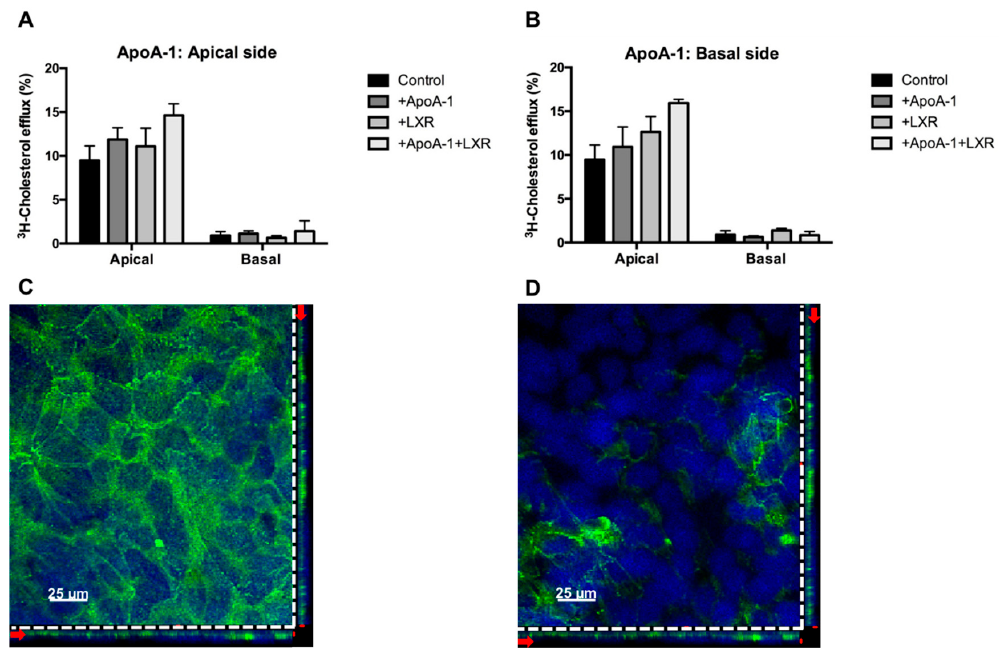
Figure 5. Transport activity and localization of ABCA1 in human primary trophoblast cells polarized on Transwell ® system. ( A , B ) The confluent trophoblast monolayer was loaded with 1 µCi of 3 H-cholesterol at the apical side for 24 h. After equilibration, 10 µg/ml of apoA-1 was added to the apical panel ( A ) or the basal side panel ( B ) for 8 h. Data are shown as mean ± SD from a representative experiment. Details of the efflux procedure are described in Materials and Methods, and ( C , D ) representative immunofluorescence staining of ABCA1 in the confluent STB monolayer. The orthogonal projections through the Z-stack suggested that ABCA1 ( green ) is predominantly expressed at the apical side (Figure 5C) while it was barely detectable at the basal side (Figure 5D) of the STB monolayer. Nuclei were counterstained with 4’,6-diamidino-2-phenylindole (DAPI, blue ). The horizontal and vertical red arrows on the orthogonal plane show the level of the selected stack. The upper level of the stack shown by the red label on the right corner of the image (Figure 5C) corresponds to the apical outer membrane. The bottom level stack marked by the red label on the right corner of the image (Figure 5D) corresponds to the basal outer membrane of the STB. Details of the staining procedure are described in Materials and Methods.